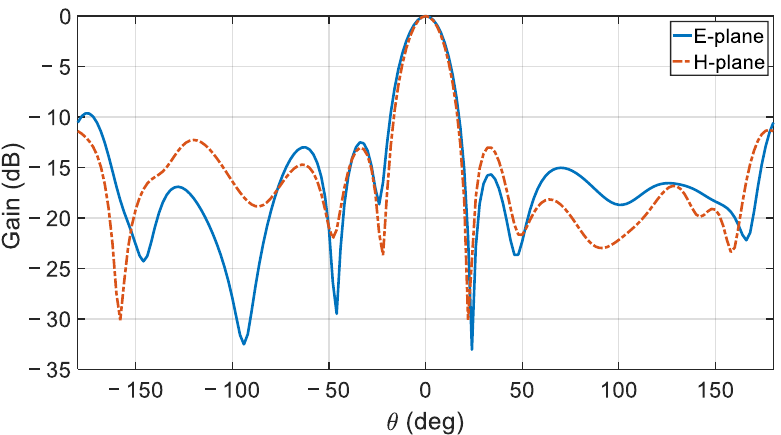
Figure 15. E- and H-plane radiation pattern at 28.52 GHz for the proposed CDRA array.